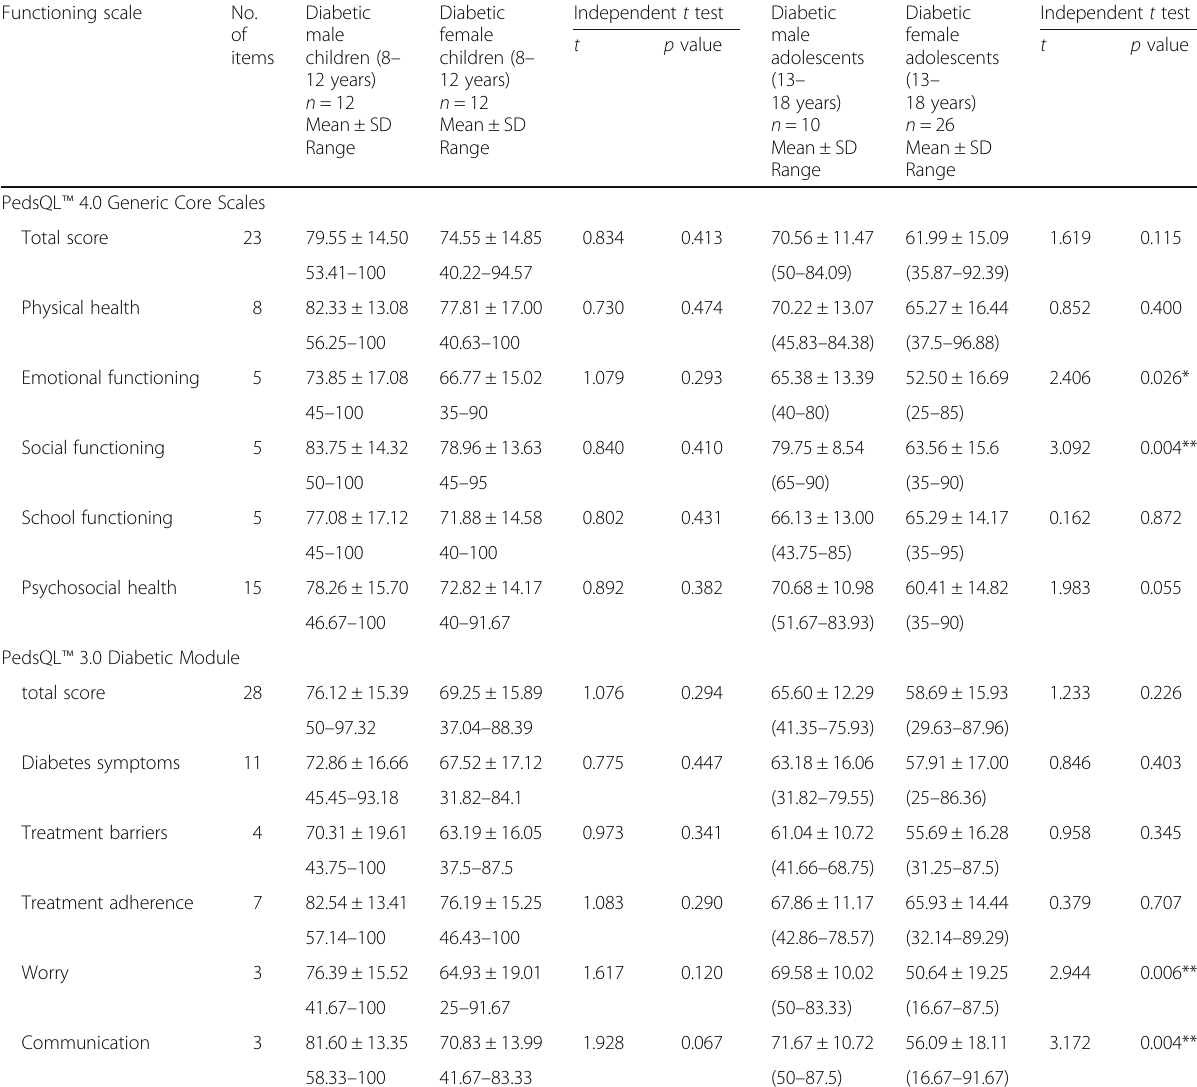
Table 4 Differentiation between male and female diabetic children (8 – 12 years) and adolescents (13 – 18 years) concerning their PedsQL ™ 4.0 Generic Core Scales (GCS) and PedsQL ™ 3.0 Diabetic